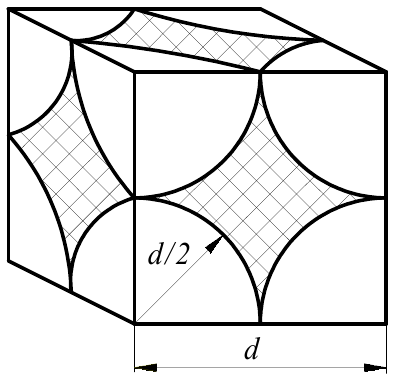
Figure 13. Same diameter spherical particles bed model.